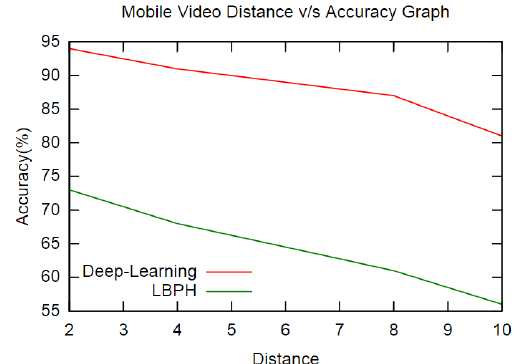
Figure 5. Comparison of LBPH and Deep Learning approach for Mobile Video at different angles Deep learning has been shown a better approach then haar classifier by comparing different angles of video, at angle zero